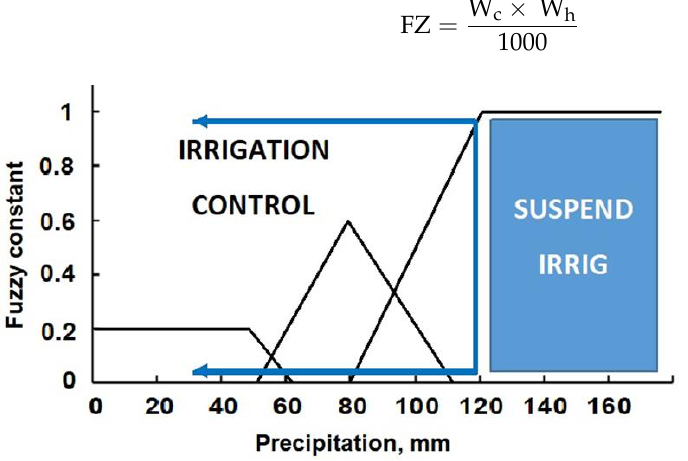
Figure 9. Flow diagram of rainfall sampling and processing.